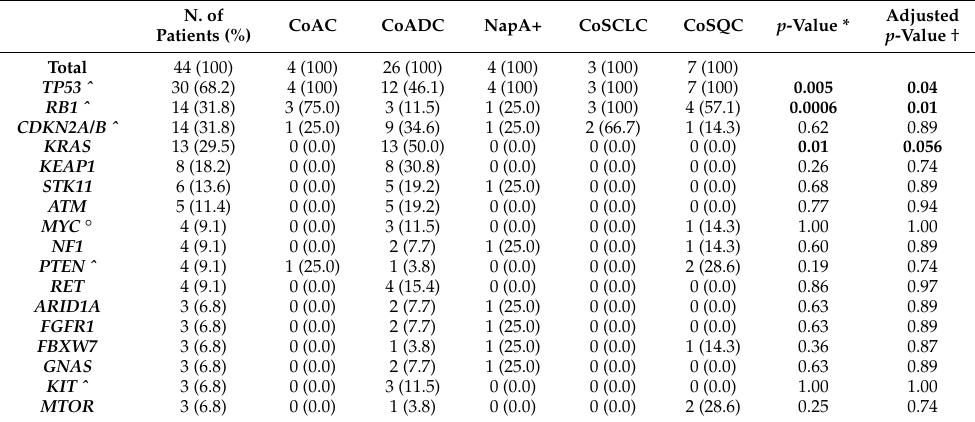
Table 2. Alteration prevalence for 17 recurrently mutated genes among combined-LCNEC groups according to their non-LCNEC component. Genes are listed according to mutation